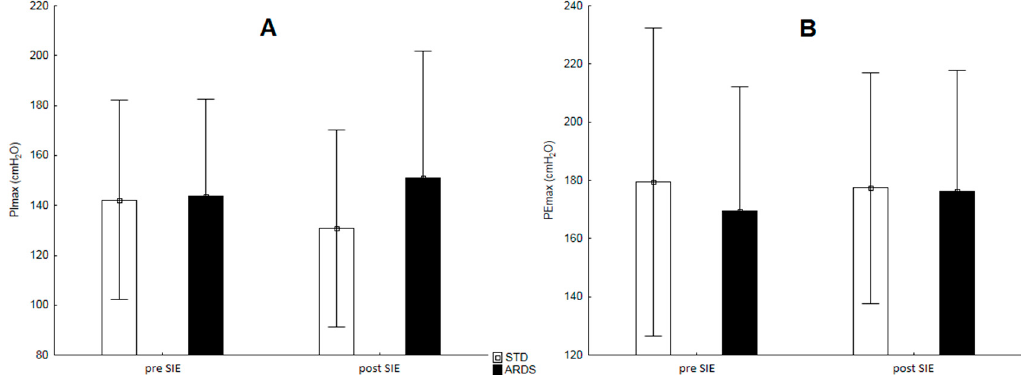
Figure 4. Changes in maximal inspiratory ( A ) and expiratory ( B ) muscle strength before and after the SIE protocols.